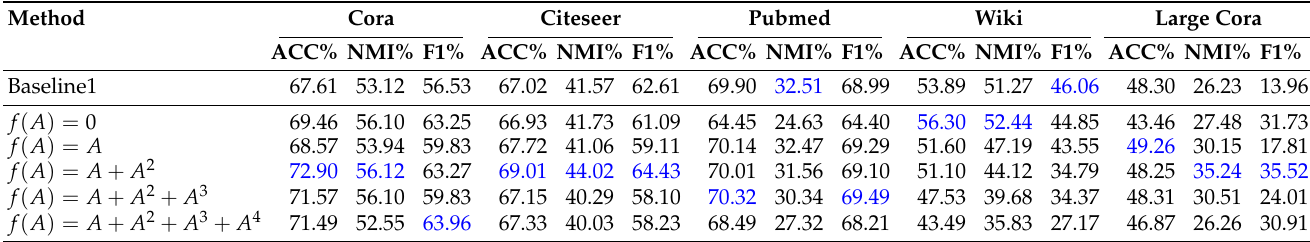
Table 4. Results of the ablation study. FGC is tested with different f ( A )